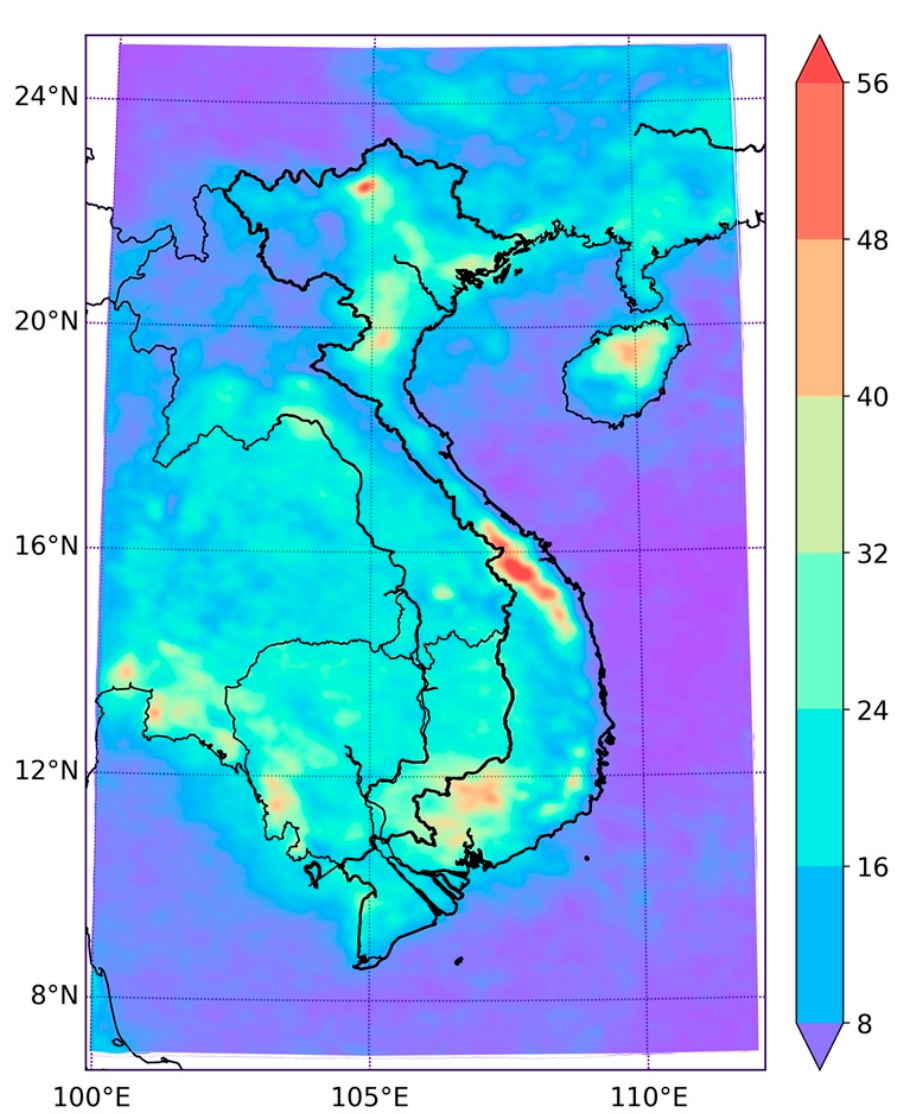
Figure 5. Annual mean lightning density (flashes km − 2 yr − 1 ) for the period 2015–2019.